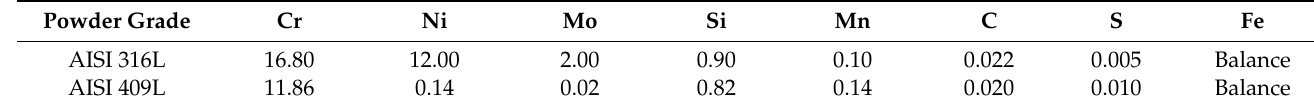
Table 1. Chemical composition of steel powders (% wt.).